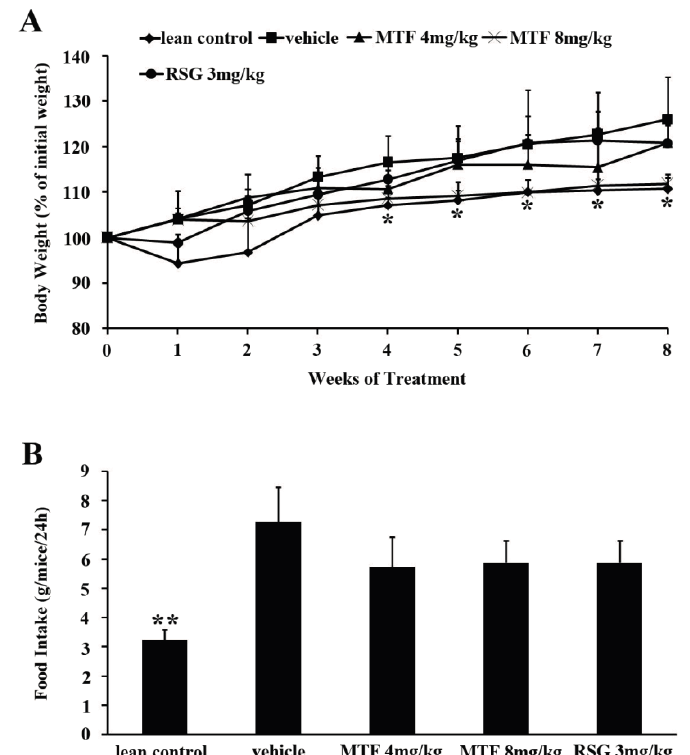
Figure 3. Body weight and food intake: ( A ) Changes of body weights in each group over the test period; ( B ) The food intake was recorded everyday during the study. Results are expressed as the mean ± SD ( n = 8). * p < 0.05; ** p < 0.01 vs.